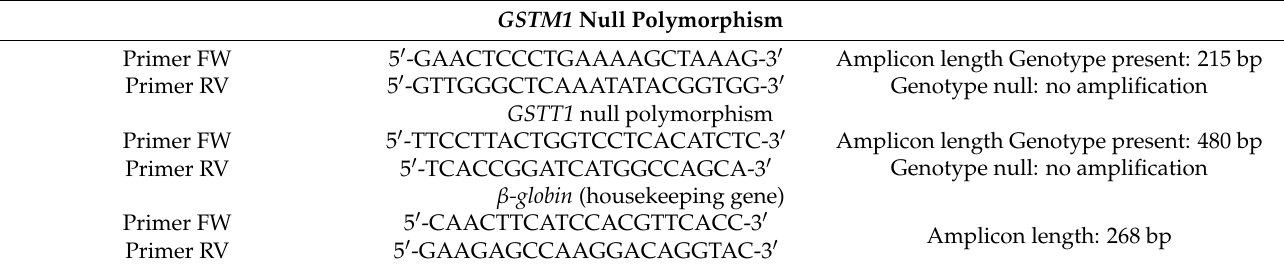
Table 2. GSTM1/GSTT1